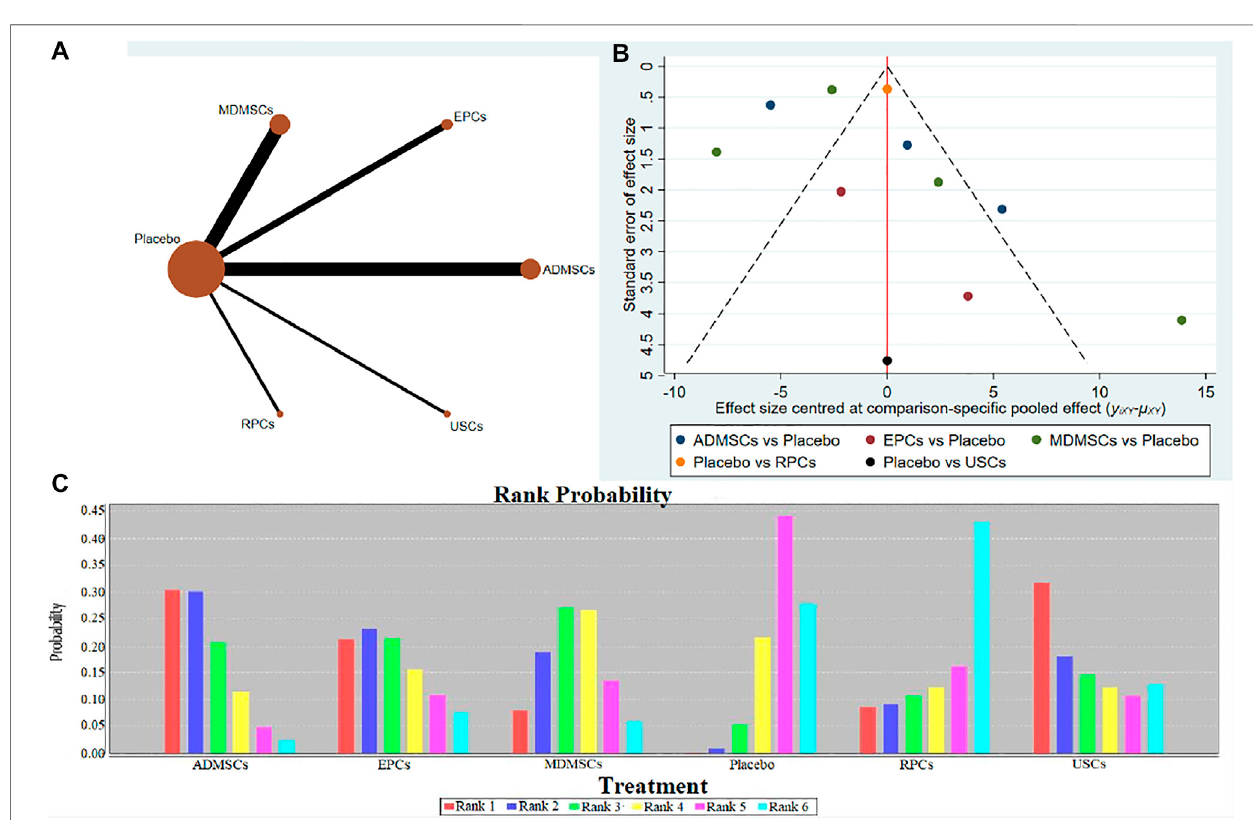
FIGURE 8 | Network Meta-analysis of blood urea nitrogen level at 14 days after administration (A) Evidence network diagram; (B) The comparison-correction funnel plot; (C) The ranking results).